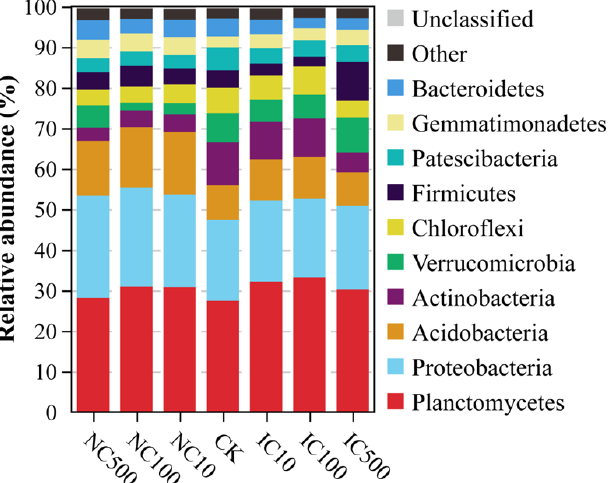
Figure 1. Soil bacterial community composition at the phylum level in different cerium treatments. Table 2. Bacterial taxa significantly correlated with cerium dose at the phylum level.